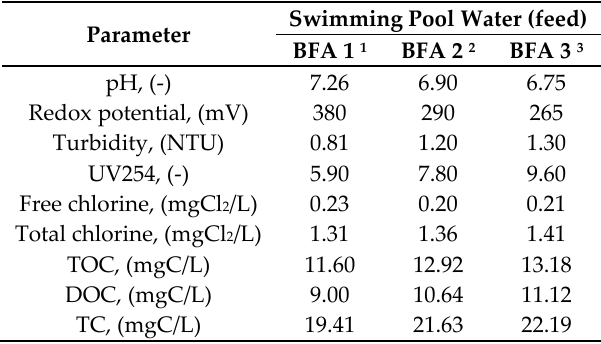
Table 2. Selected physicochemical parameters of feeds for nanofiltration.